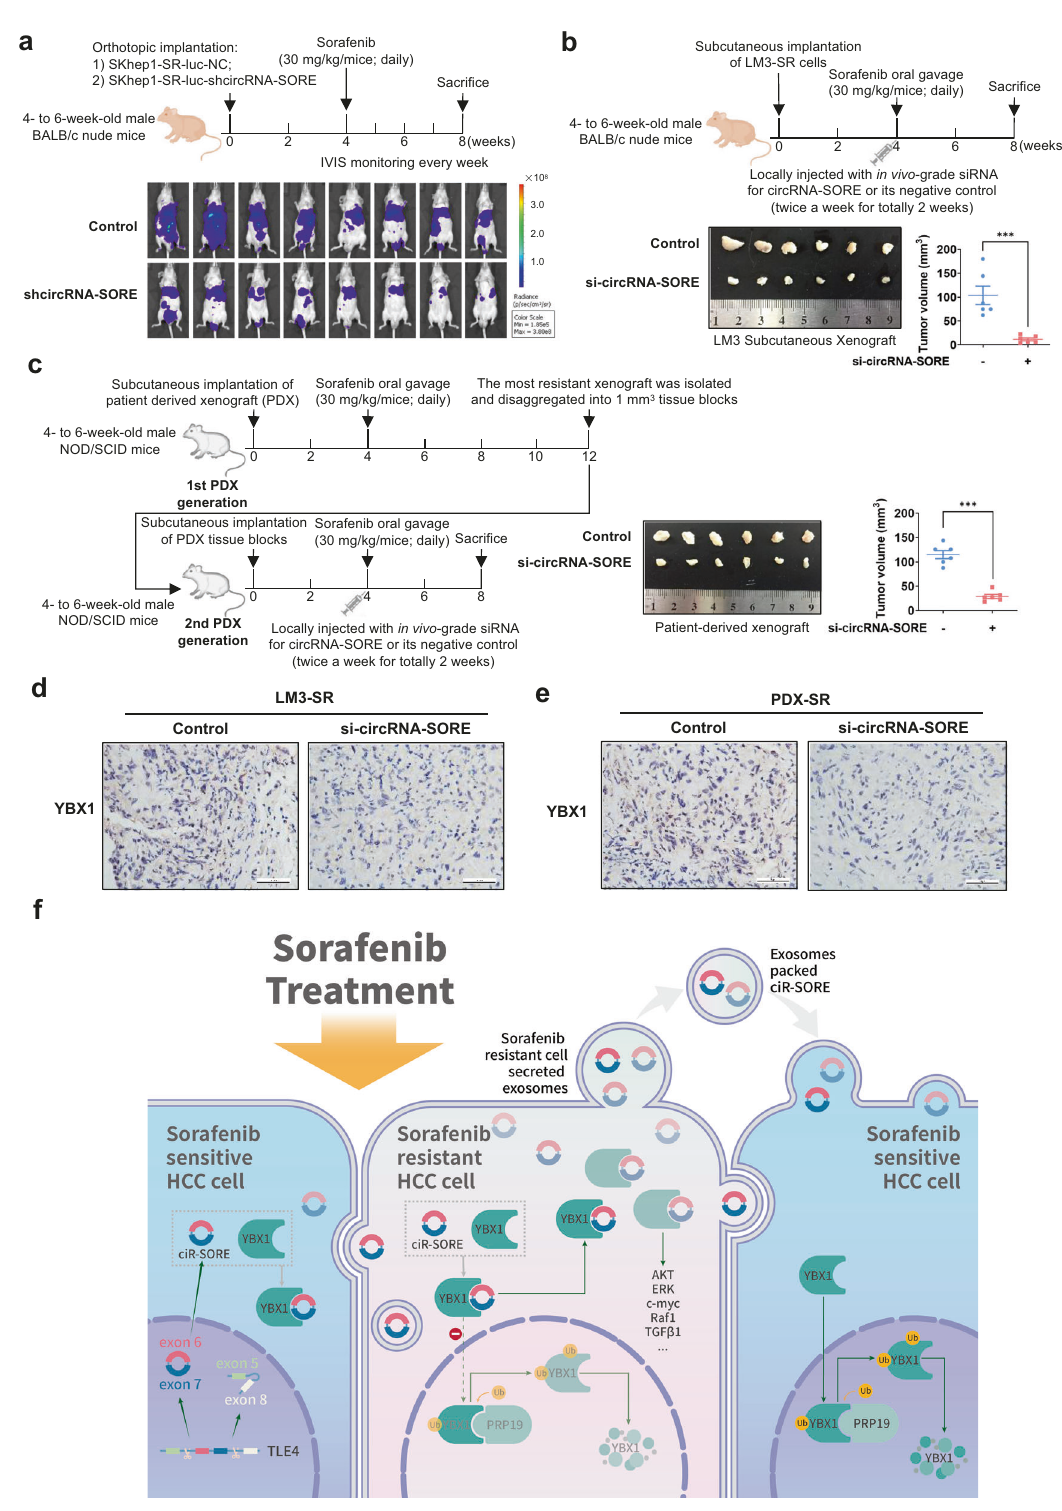
MATERIALS AND METHODS RNA pull-down For biotinylated RNA pull-down assays, transfected HepG2-SR cell lysates were incubated with MyOne ™ Dynabead ® Streptavidin C1 beads (Invitrogen, USA) at 4 °C for 1 h. For biotinylated-probe pull- down assays, MyOne ™ Dynabead ® Streptavidin C1 beads were